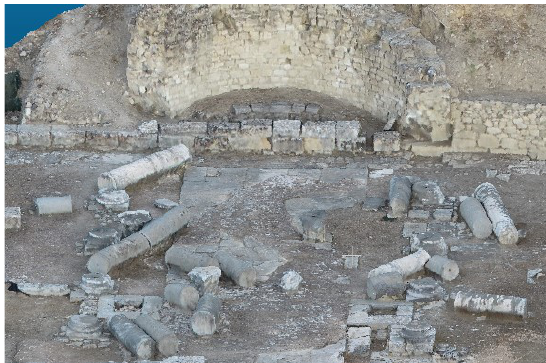
Figure 4. Photogrammetric reconstruction of architectural elements inside the temple.